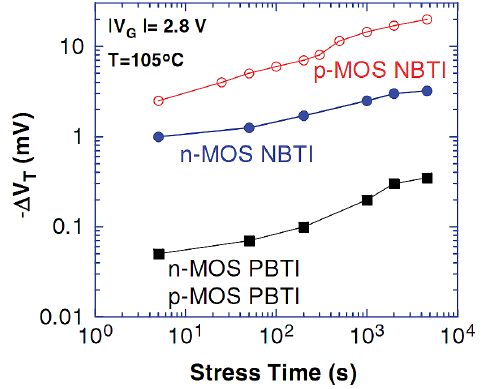
Figure 1. Comparison of NBTI and PBTI in both nMOS and pMOS devices